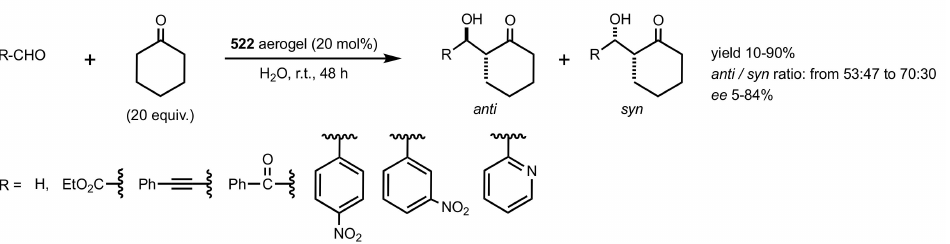
Scheme 138. Aldol reactions catalysed by chitosan 522